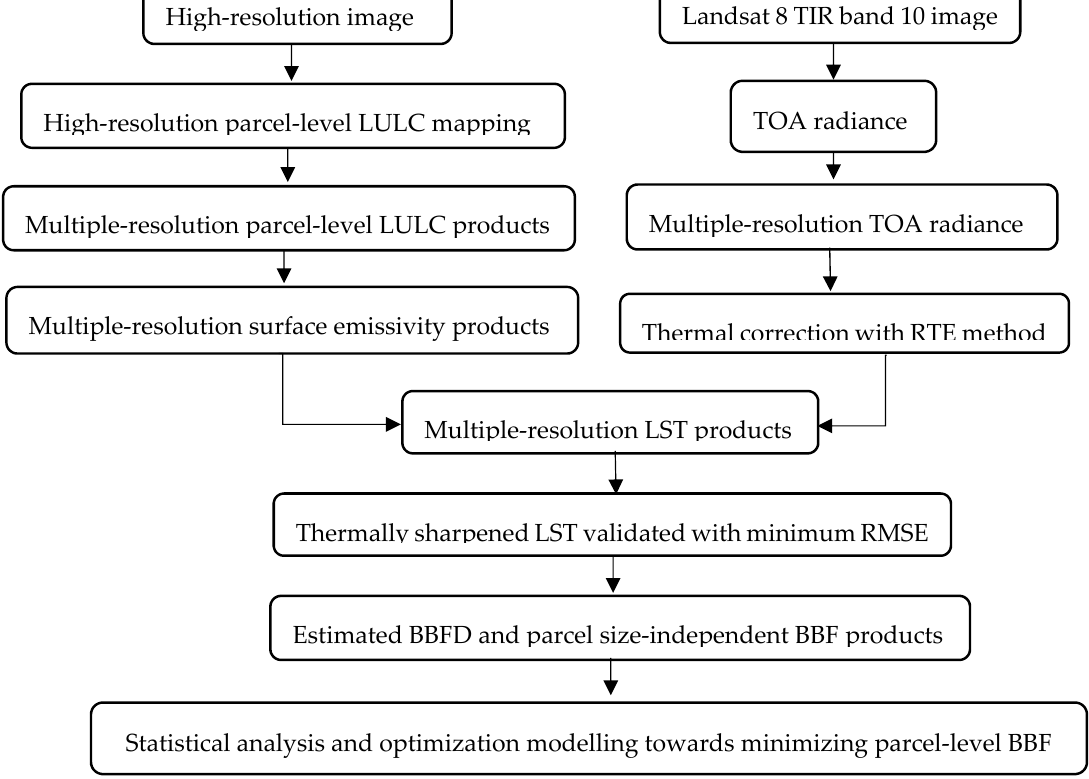
Figure 2. Flowchart of this study.